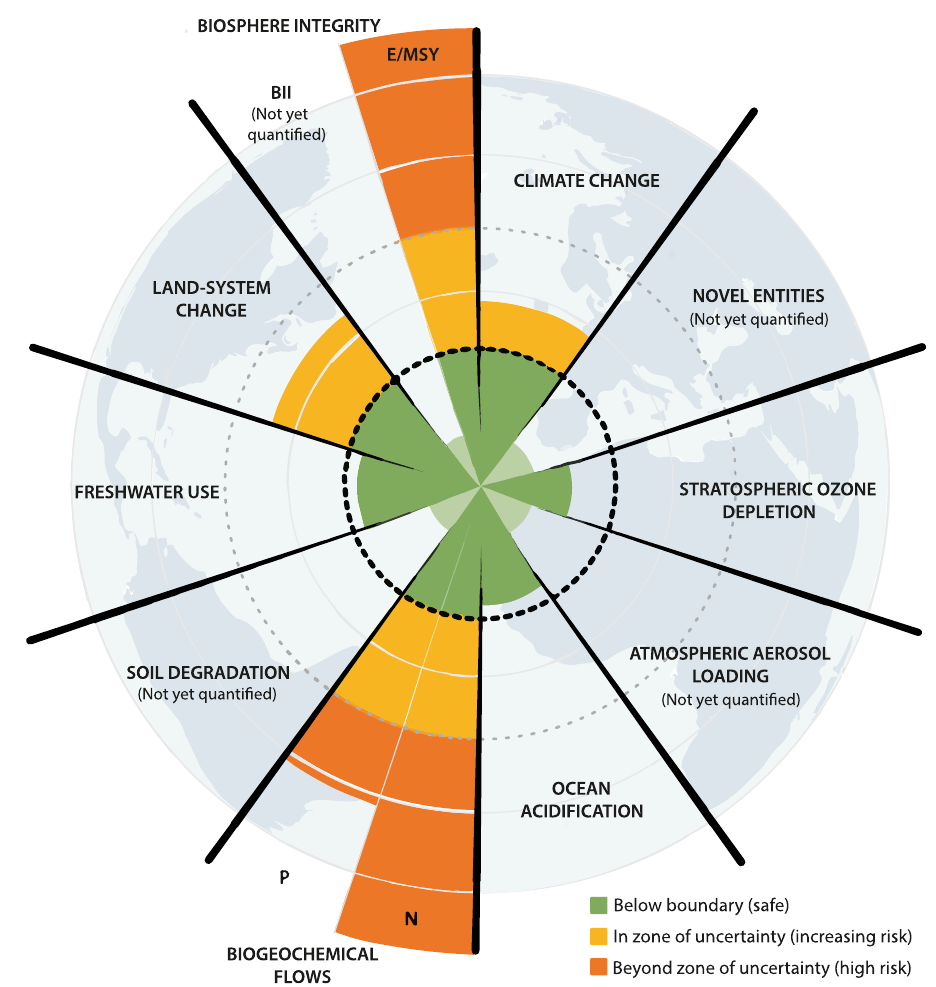
Fig. 2 Proposed new planetary boundaries framework. Updated version of the planetary boundaries framework portraying the current nine Earth system processes along with soil degradation as the 10th Earth system process. The small circle (bold dotted line) represents the planetary boundaries. The large circle (regular dotted line) portrays the thresholds. Adapted from the original image of the planetary boundaries framework constructed by J. Lokrantz/ Azote based on Steffen et al. 2 . Licensed under